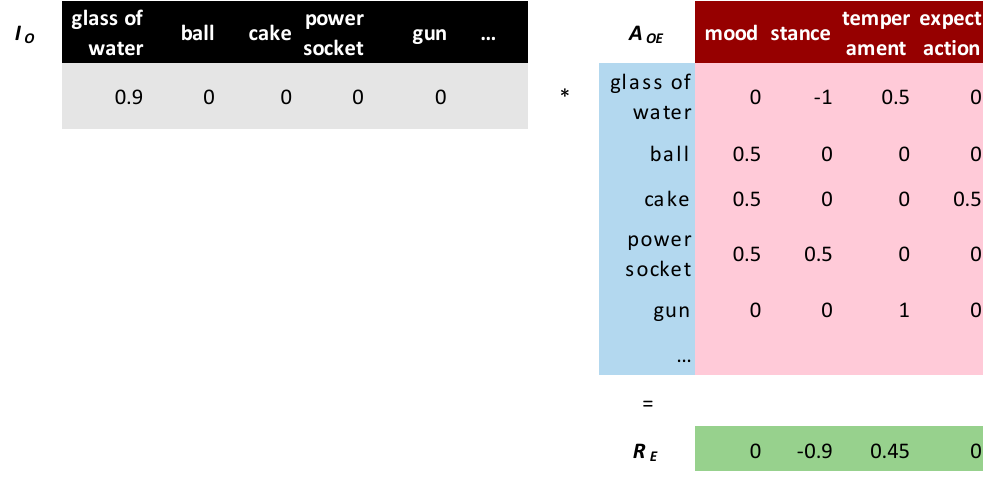
Figure 6. Summary of the object-to-emotion affordance process.